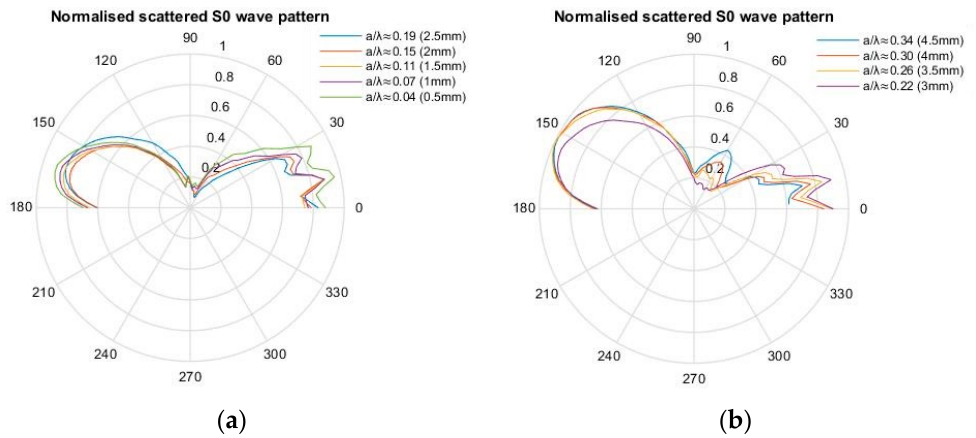
Figure 8. FE-normalised scattered wave polar plot of S0 waves with respect to the incident wave maximum displacement. ( a ) 0.04 ≤ a/ λ ≤ 0.19; ( b ) 0.22 ≤ a/ λ ≤ 0.34.